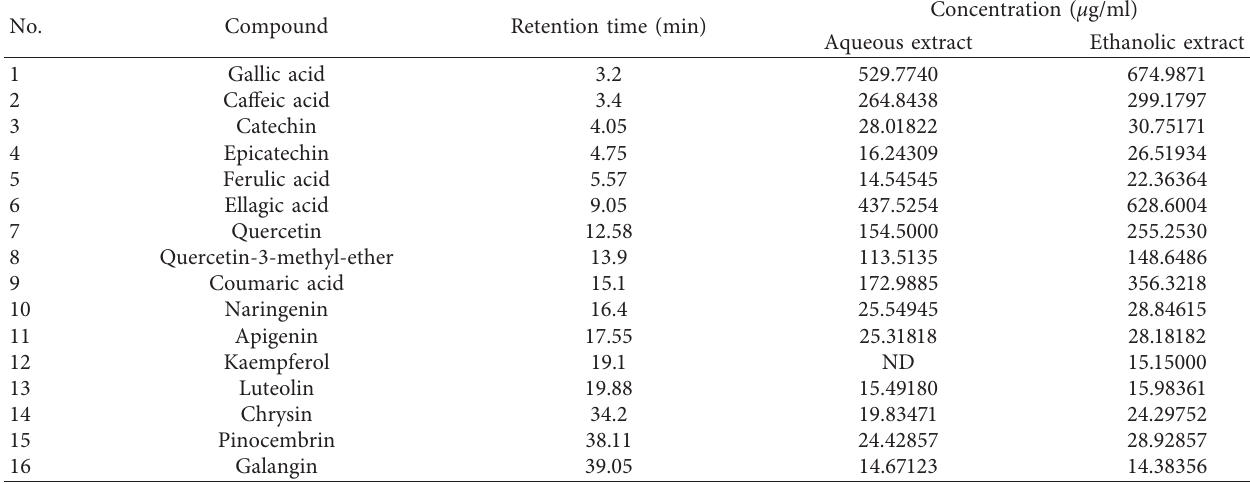
Table 1: Phenolic compound concentration in pomegranate peel extracts.